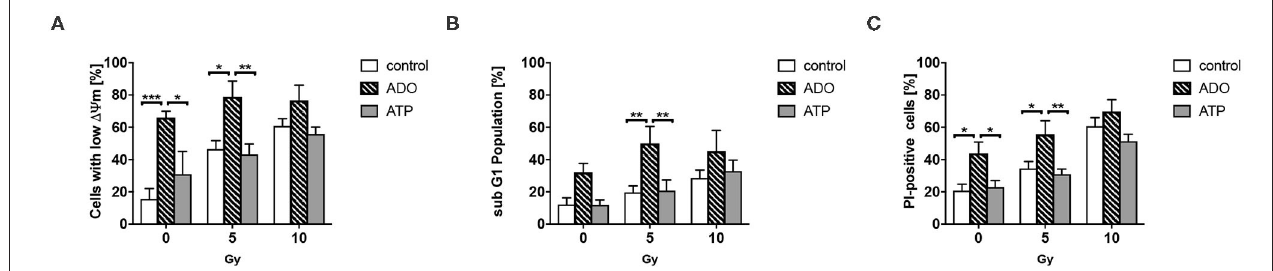
FIGURE 3 | Effects of extracellular ATP and Ado on LLC1 tumor cells in vitro . LLC1 cells were incubated with ATP (2 mg/mL) or Ado (1 mg/mL) 1h prior to 0-, 5-, or 10-Gy irradiation. Forty-eight hours later, cells were stained with TMRE or PI and further analyzed with flow cytometry to investigate the (A) mitochondrial potential ( 19 m), (B) the sub-G1 fraction (apoptosis), and (C) PI-positive cells (cell death). Data show means ± SEM; * P ≤ 0.05, ** P ≤ 0.01, *** P ≤ 0.001 by two-way ANOVA followed by post hoc Tukey test.